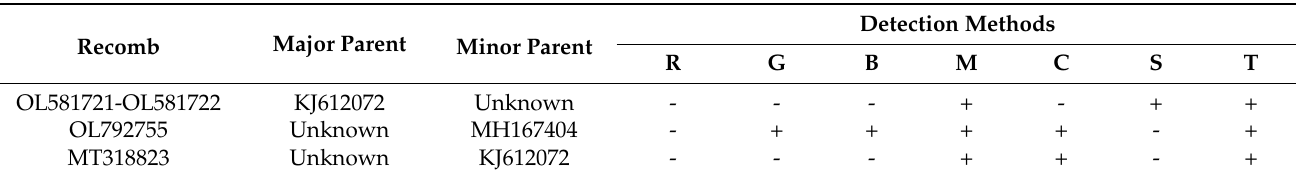
Table 2. Recombination event in P1 strains.